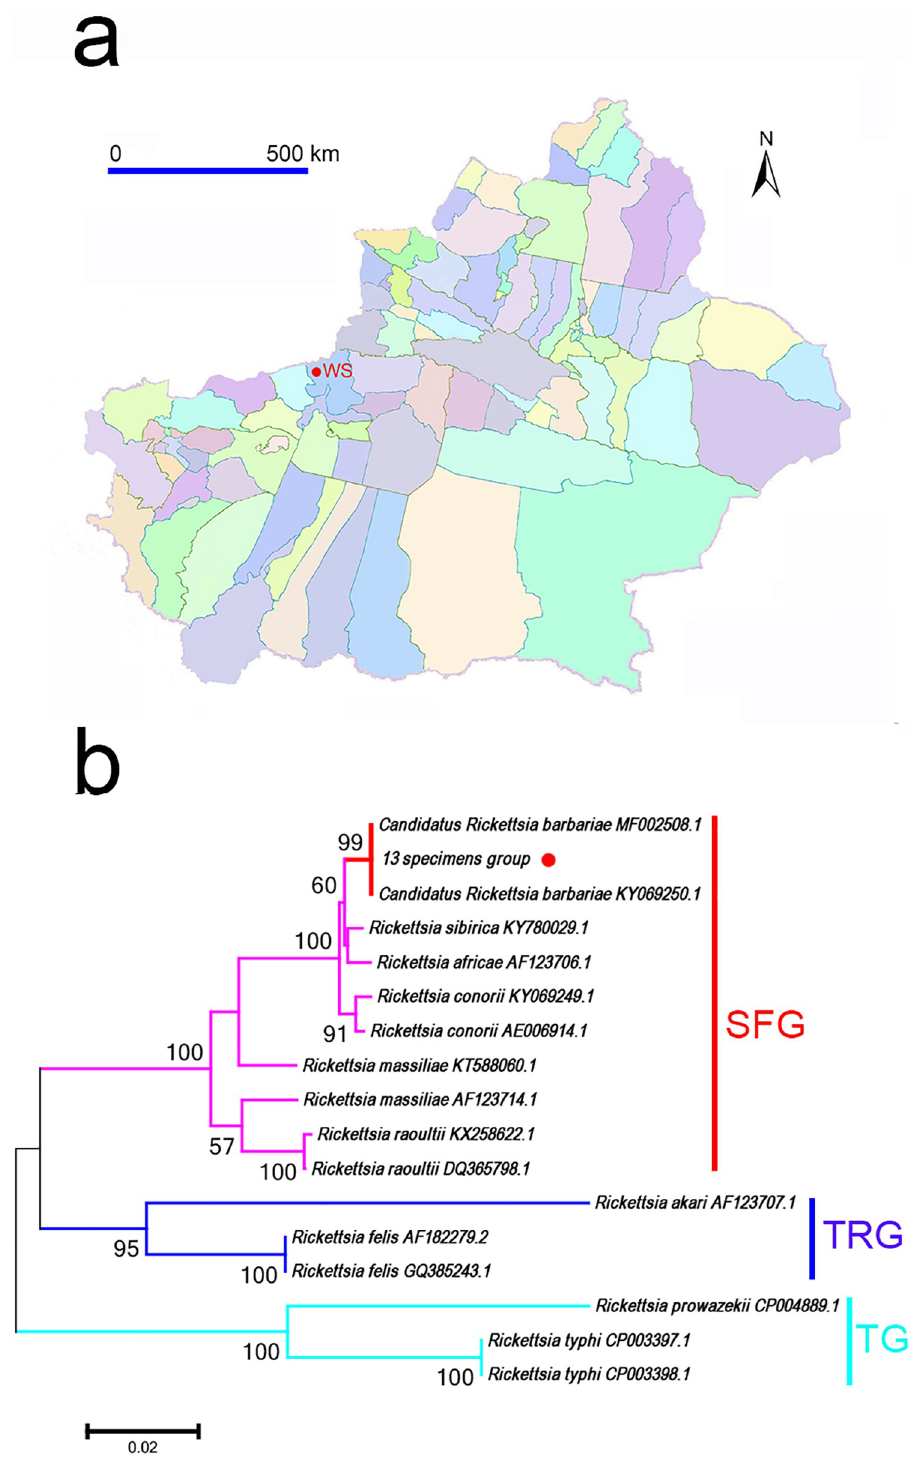
Fig 2. Detection and analysis of Rickettsia spp. in argasid ticks from southern Xinjiang. A. The sampling site of Rickettsia spp-positive tick is marked with red dot. B. Neighbour joining phylogenetic analysis based on partial ompB sequences of Rickettsia spp. Bootstrap values are indicated at the nodes. Scale bar indicates the degree of divergence represented by a given length of branch. The red dots indicate the sequences acquired in this study. SFG indicates the spotted fever group. TG indicates the typhus group. TRG indicates the transitional group of Rickettisa spp. Abbreviations : WS,